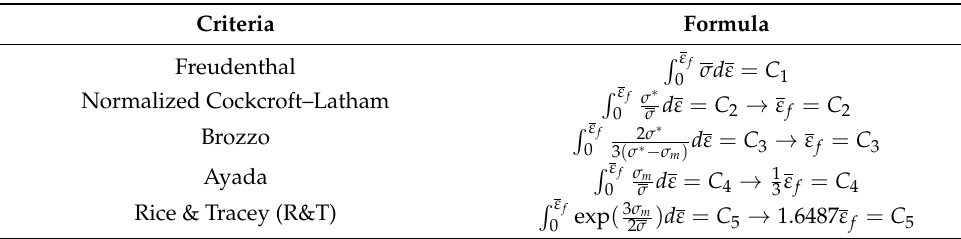
Table 7. DFCs used in the present work.